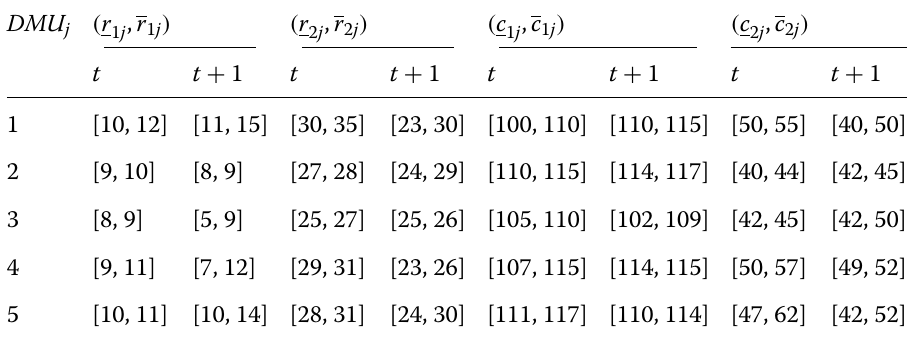
Table 2 Numerical example